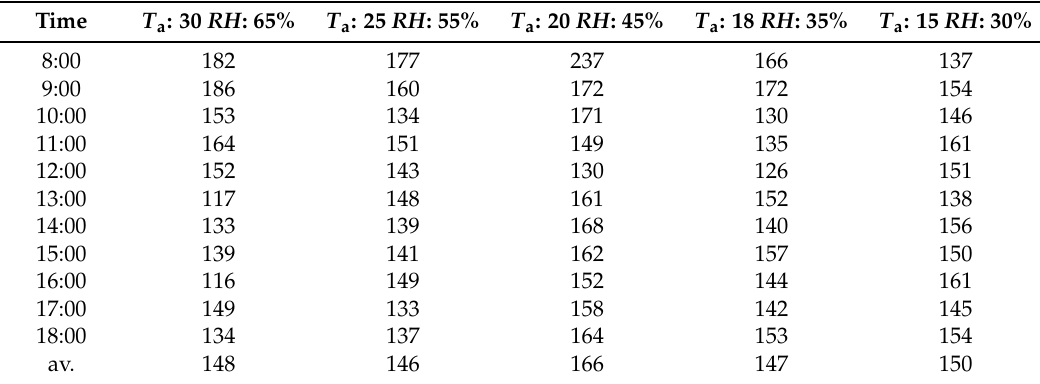
Table 2. r a – loc (s/m) measured at a height of 1